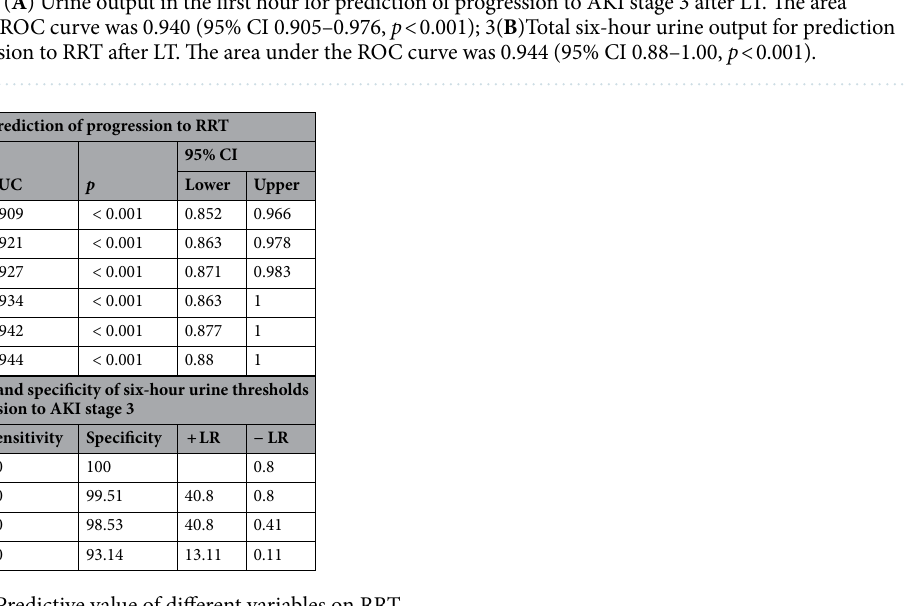
Table 3. Predictive value of different variables on